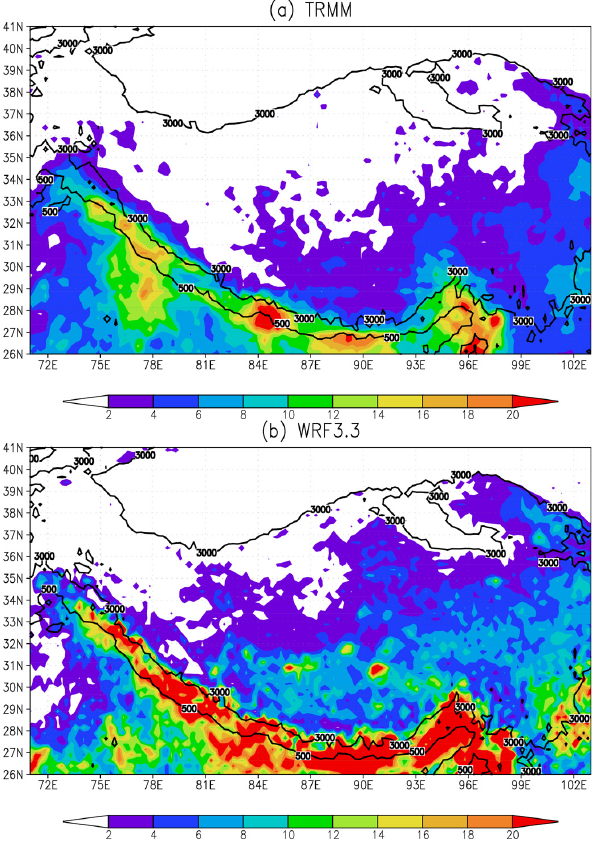
Fig. 2. Precipitation (mmday − 1 ) averaged in July 2003: (a) TRMM data, (b) model simulation. Solid lines indicate the 3000 and 500m topographies,